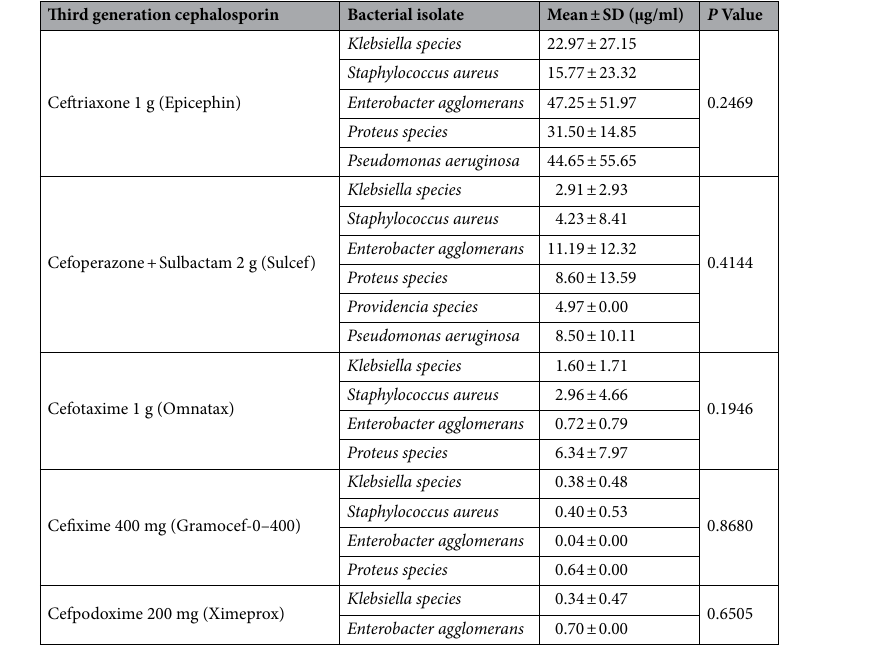
Table 4. The MICs for susceptible isolates to third generation